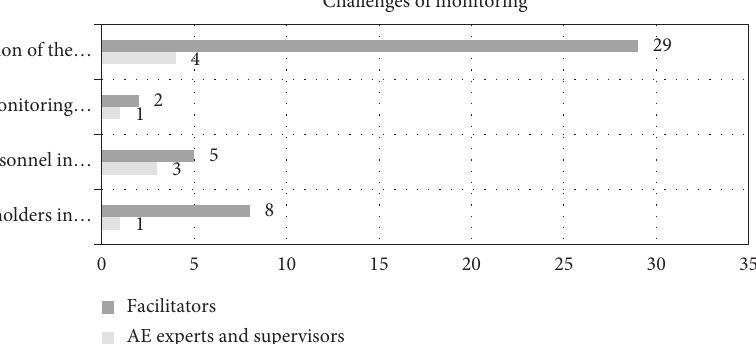
Figure 3: Major challenges of IFAE following